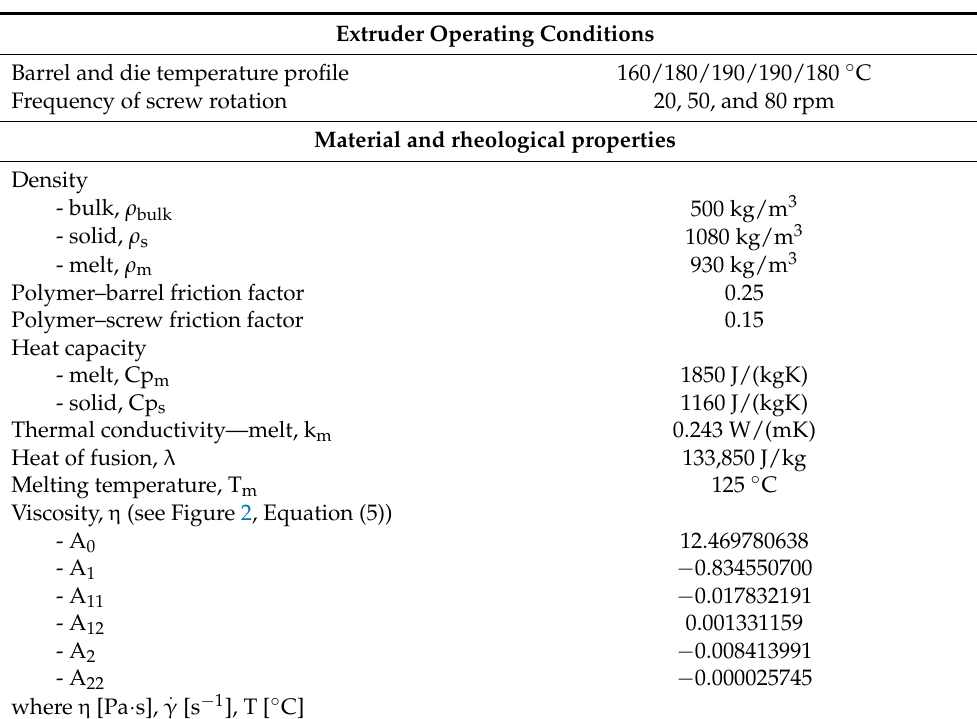
Table 2. Composite properties and processing